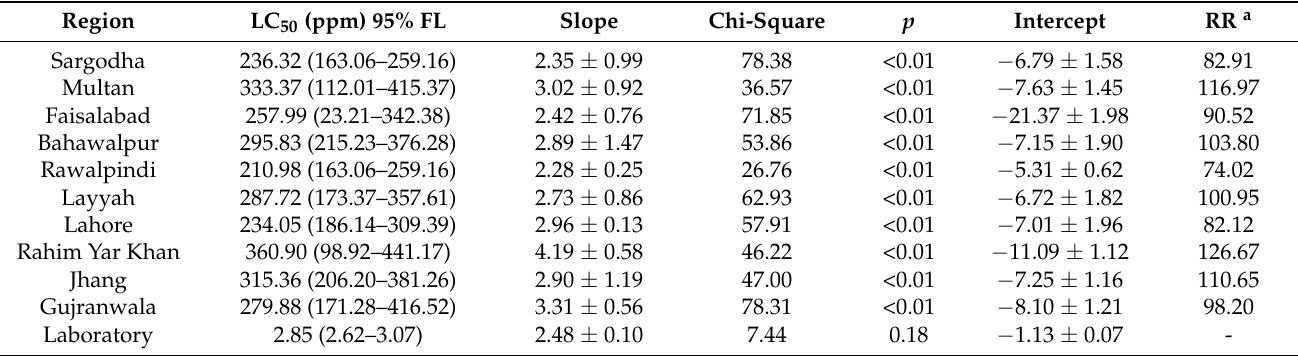
Table 1. Probit analysis of mortality for 10 field-collected populations and a laboratory-susceptible population of Rhyzopertha dominica adults after 20 h of exposure to phosphine. In all cases DF =